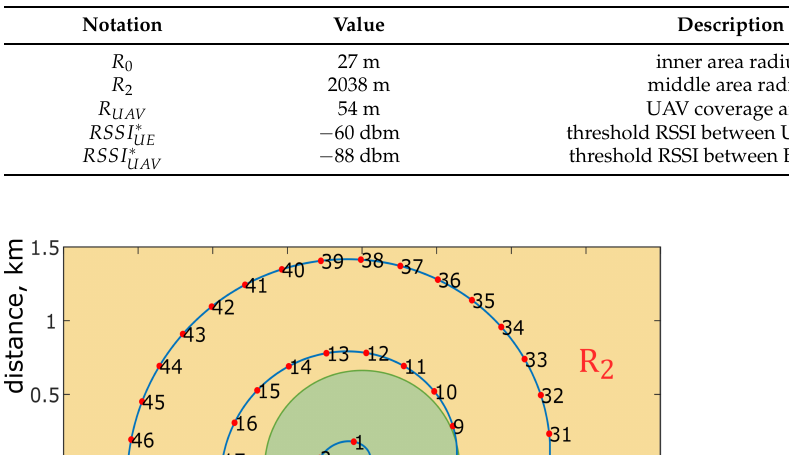
Table 3. Calculated data.